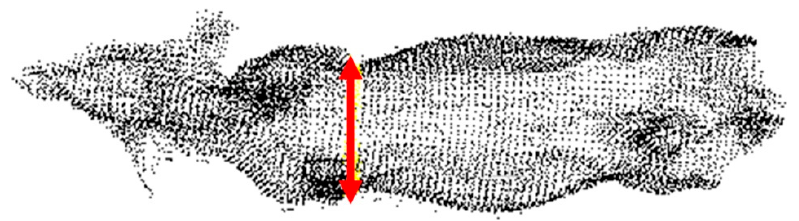
Figure 14. The location of the body width calculation position.